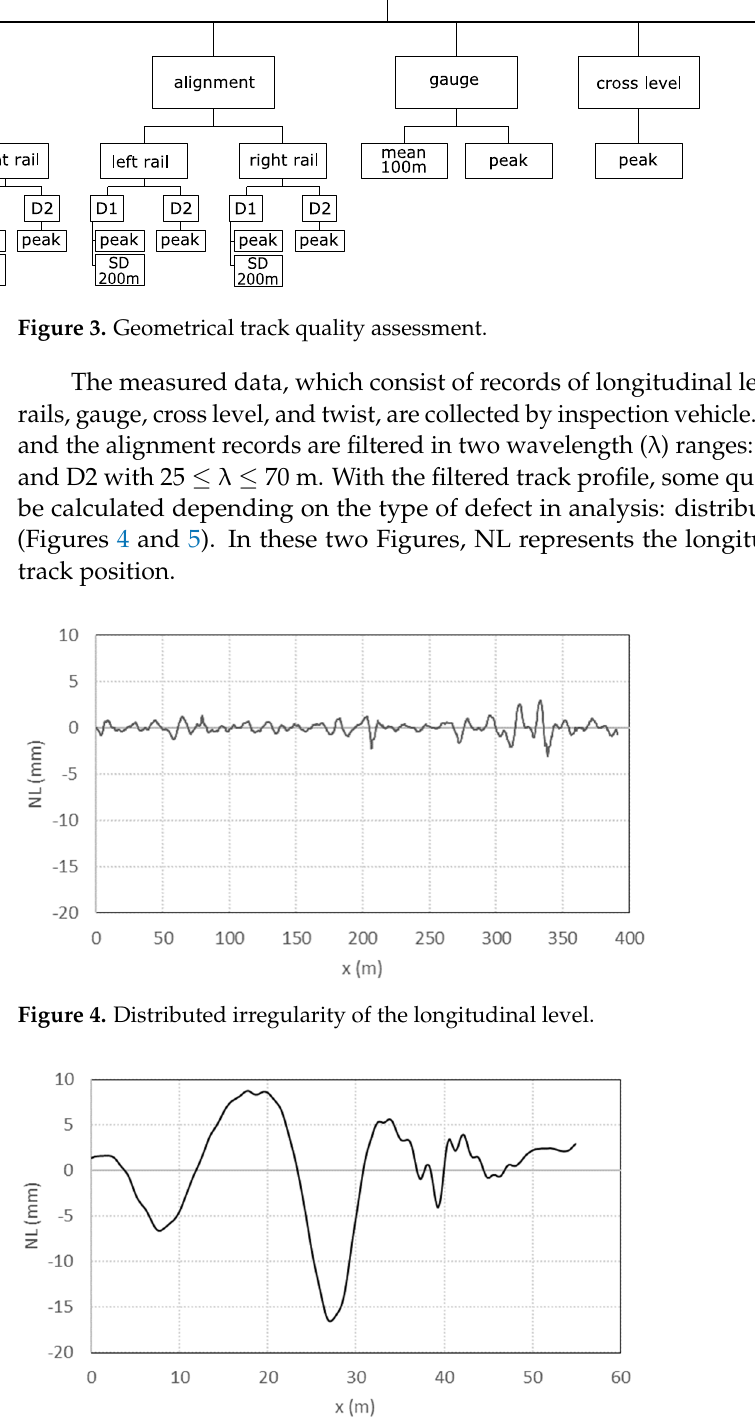
Figure 5. Isolated irregularity of the longitudinal level.